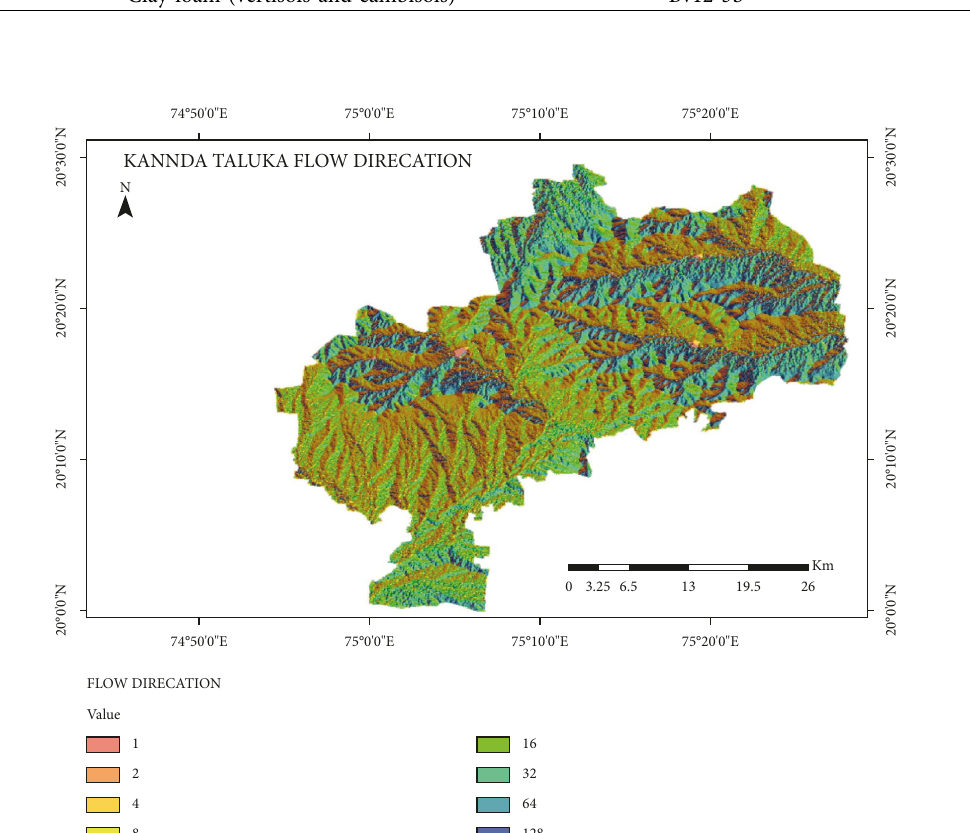
Figure 8: Flow direction map of Kannad